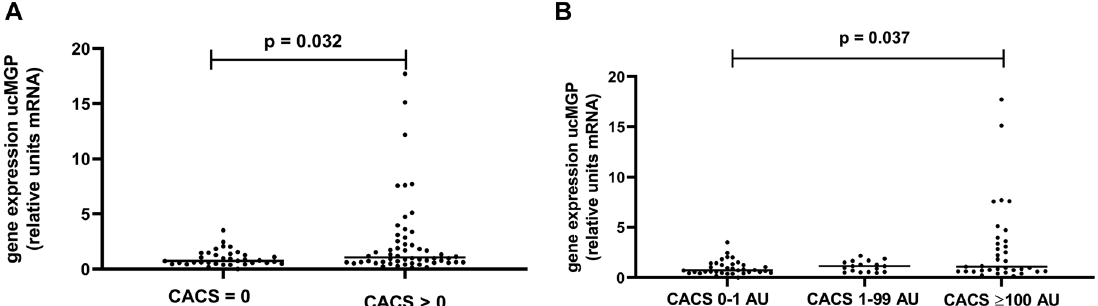
Figure 2: ucMGP expression levels in PBMC according CAC score. Dataarepresentedasmean ± standarderrorofmean(SEM).Geneexpressioniscalculatedwiththe2 − ΔΔ Ct methodwherethevalueofmRNAinthe calibratorgroup(n=9)isconsideredequalto1.(A).ChangesinucMGPexpressioninpatientswithoutarterialcalcium(CACS=0)andpatientswith arterial calcium (CACS>0); (B). Changes in ucMGP expression when the patients were subdivided according to CACS levels. Where the p-value is not speci fi ed, the differences between the subgroups are non-signi